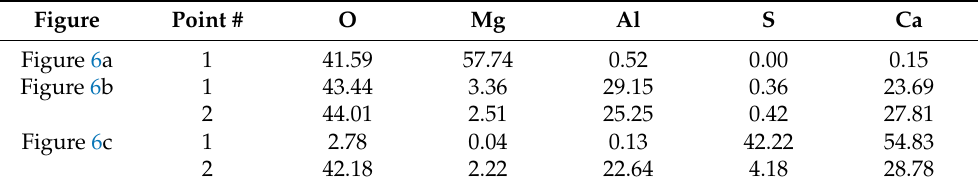
Figure 6. Secondary electron images of ( a ) MgO, ( b ) calcium aluminate, ( c ) calcium aluminate–CaS ‐ type NMIs. Table 2. EDS analyses (in wt%) for the NMIs presented in Figure 6.